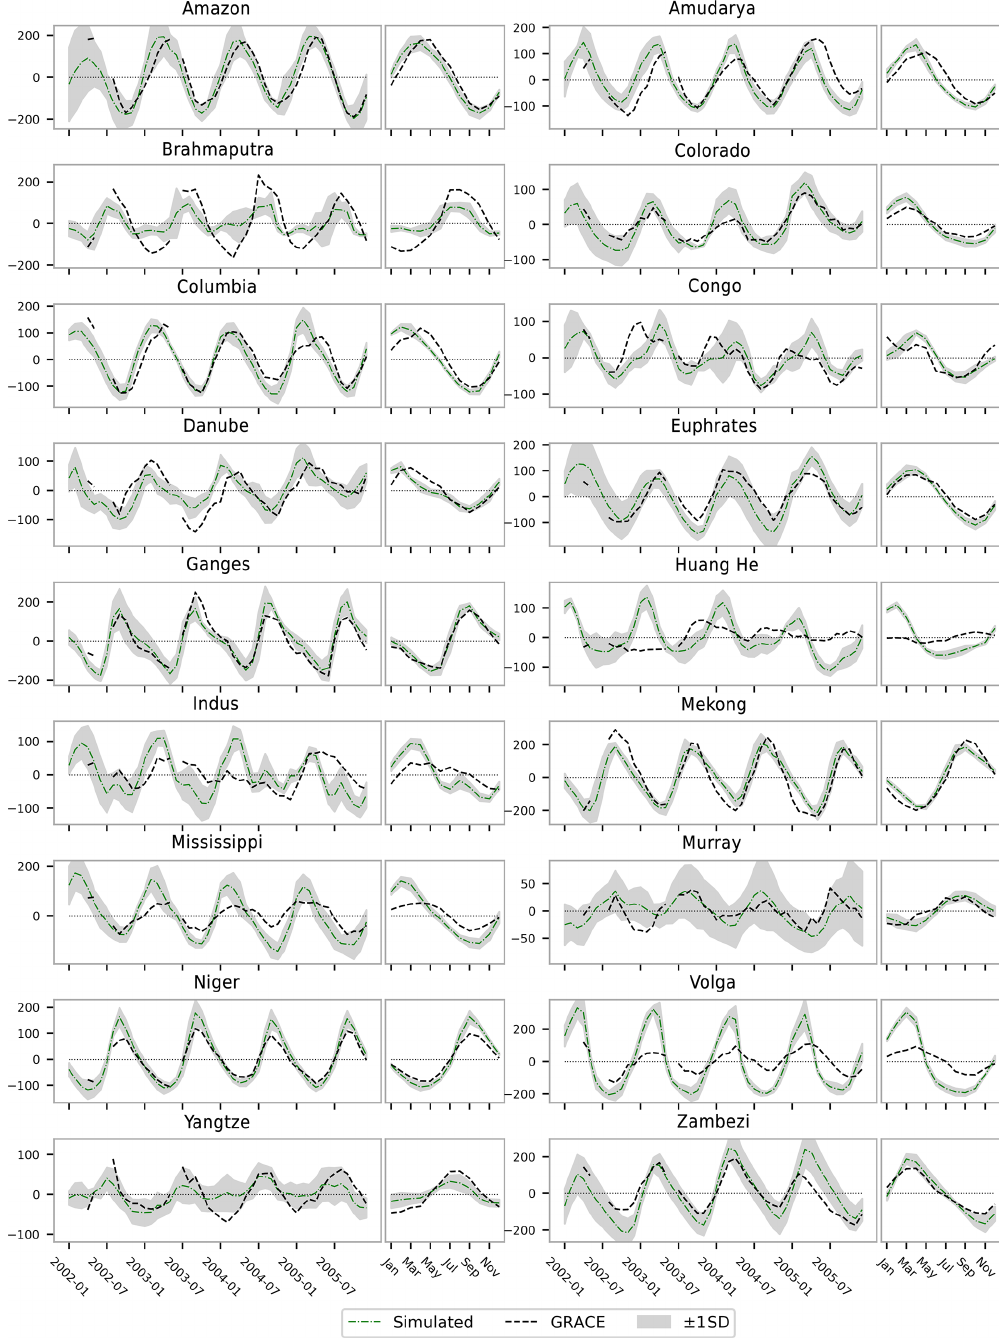
Figure 3. Comparison of historical terrestrial water storage (TWS) simulated by MIROC-INTEG-LAND with GRACE satellite data. For each river basin, the panel to the right shows the seasonal cycle. The GRACE data shown are the mean of the mass concentration products from two processing centers: CSR and JPL. Simulated results are the average of five climate model simulations. Grey shading indicates the uncertainty range shown by 1 standard deviation from the